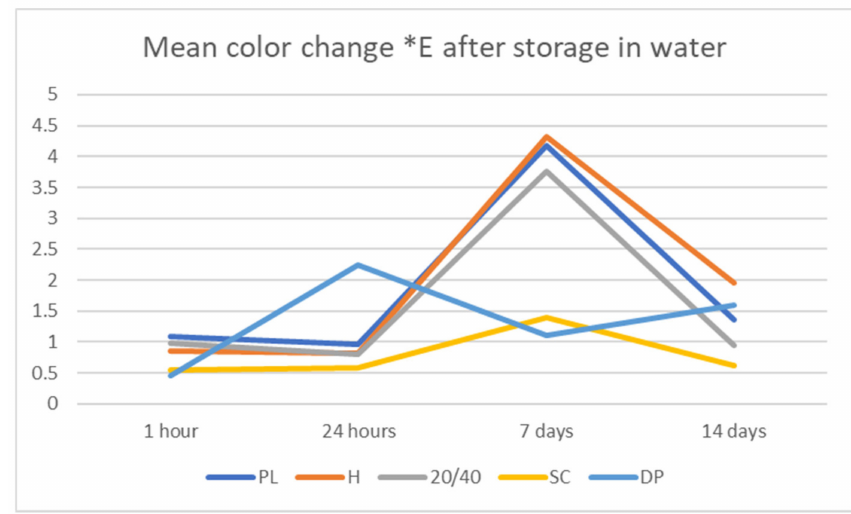
Figure 2. Mean color change ∆ E* after storage in water.